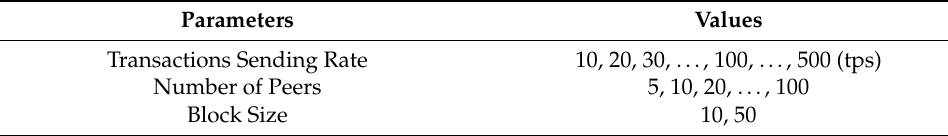
Figure 6. Transactions sending rate vs. latency—a single host case. Table 2. Network nodes and load